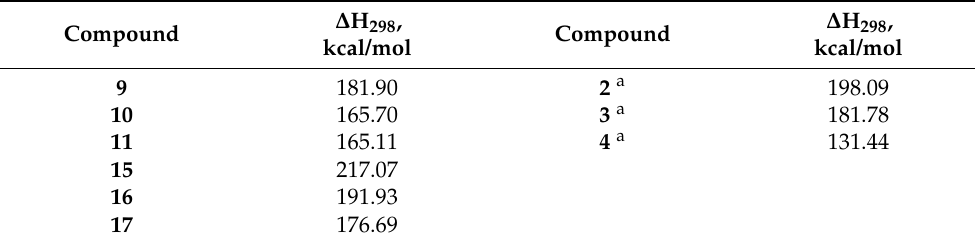
Table 3. Calculated values of EOFs ( ∆ H 298 ) of compounds 9 – 11 and 15 – 17 (B3LYP 6-311 + G*).